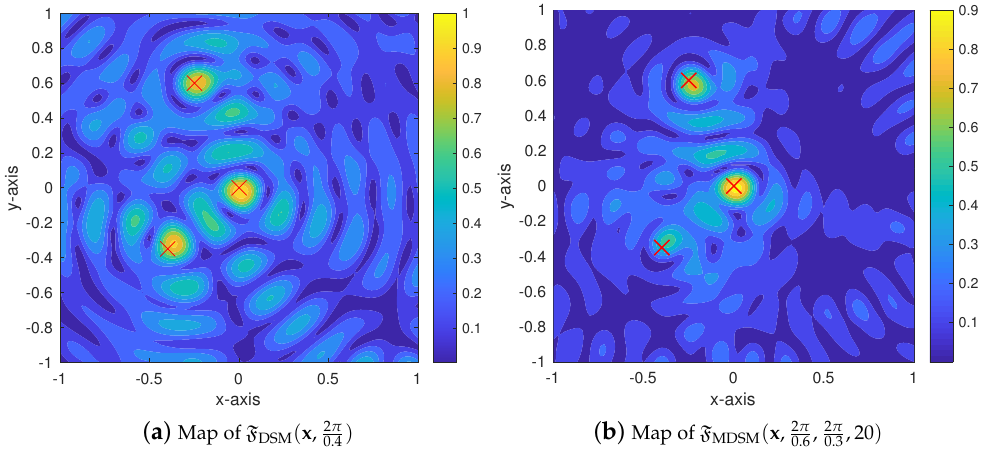
Figure 7. (Example 5) Simulation results with d = ( 1,0 ) . The red-colored marks × denote the locations of